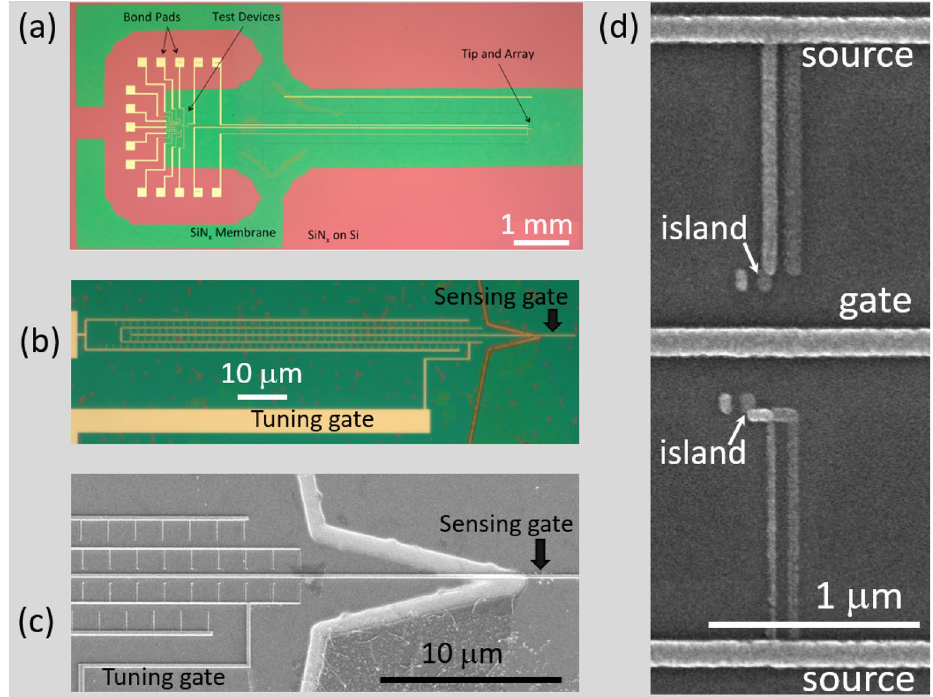
AlO X SEBA fabricated using Dolan bridge technique ( a ) Optical micrograph of Figure 3. Micrographs of Al − the SEBA on SiN X membrane (green) fabricated on top of oxidized Si wafer. ( b ) Zoom-in view showing SEBA with 2 gates (sensing and tuning). The trench defining the tip is etched into Si membrane using reactive ion etching ( c ) Electron micrograph of SEBA (30 SEBs are visible out of 200 total) on SiN X substrate. ( d ) Electon micrograph of two SEBs, the sensing gate is in the middle. All of the devices studied in this work are fabricated on fused silica substrate.